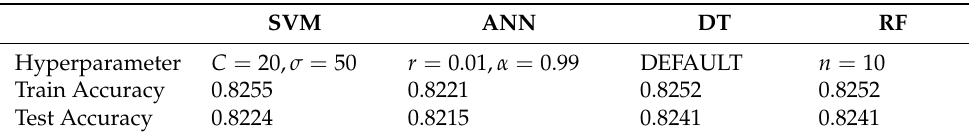
Table 11. Data3 optimal classification results.